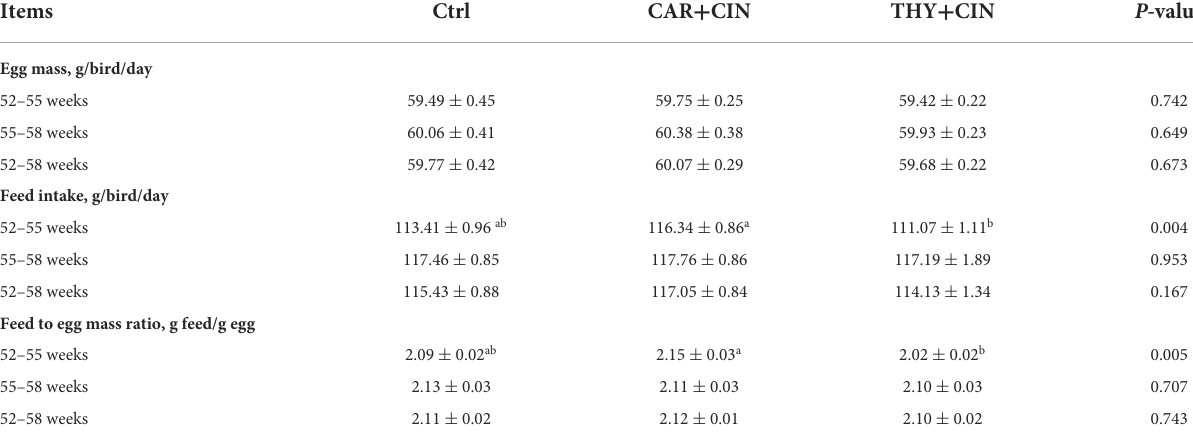
TABLE 4 Effects of dietary treatments on egg production of the post-peak laying